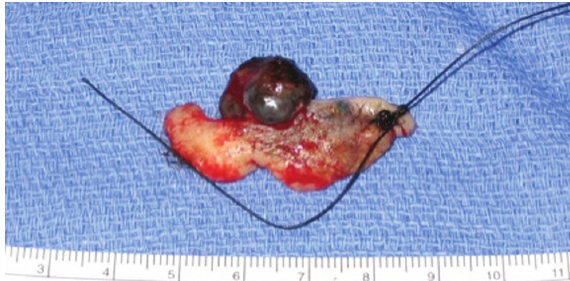
Figure 1: To remove the melanoma lesion, a full-thickness defect was created to excise the lower lid from the sidewall of the nose, down to the level of the inferior orbital rim.